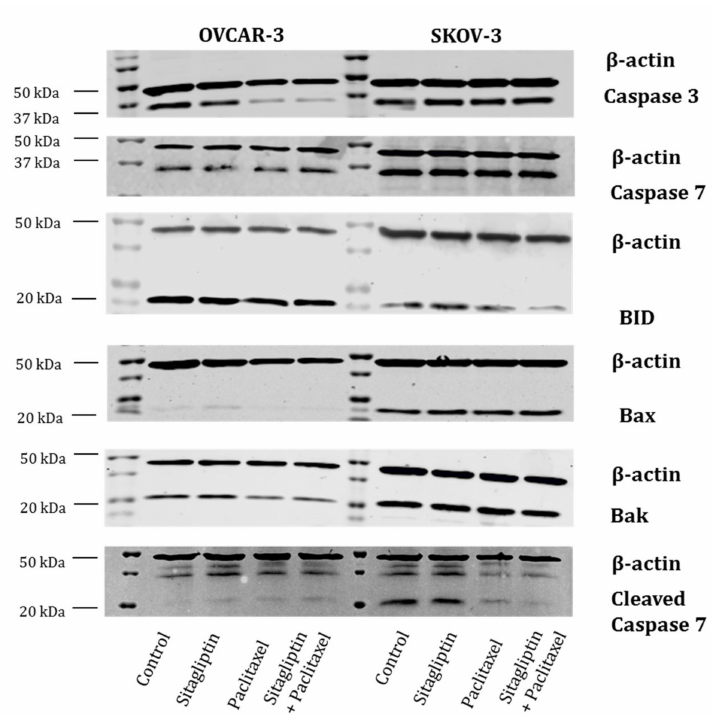
Figure 5. Western blots. Caspase 3, caspase 7, BID, Bax, Bak, cleaved caspase 7. Representative western blot image of protein extracts from OVCAR-3 and SKOV-3. Ovarian cancer cell lines: Control cells, cells stimulated for 24 h with sitagliptin (50 µ M), paclitaxel (10 nM), or sitagliptin (50 µ M) and Paclitaxel (10 nM).